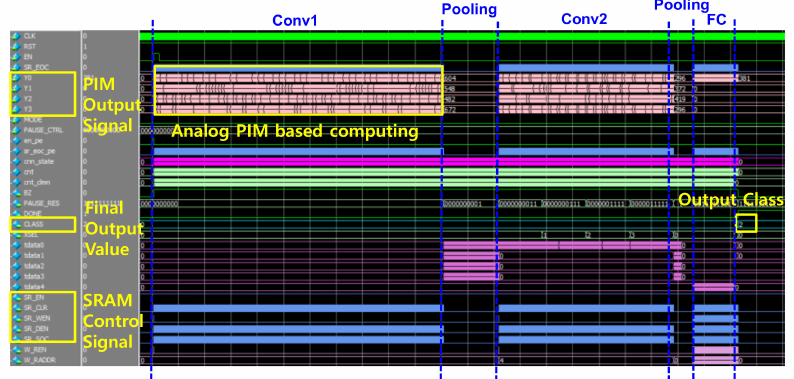
Figure 12. The simulation result of top CNN includes PIM to analyze classification.